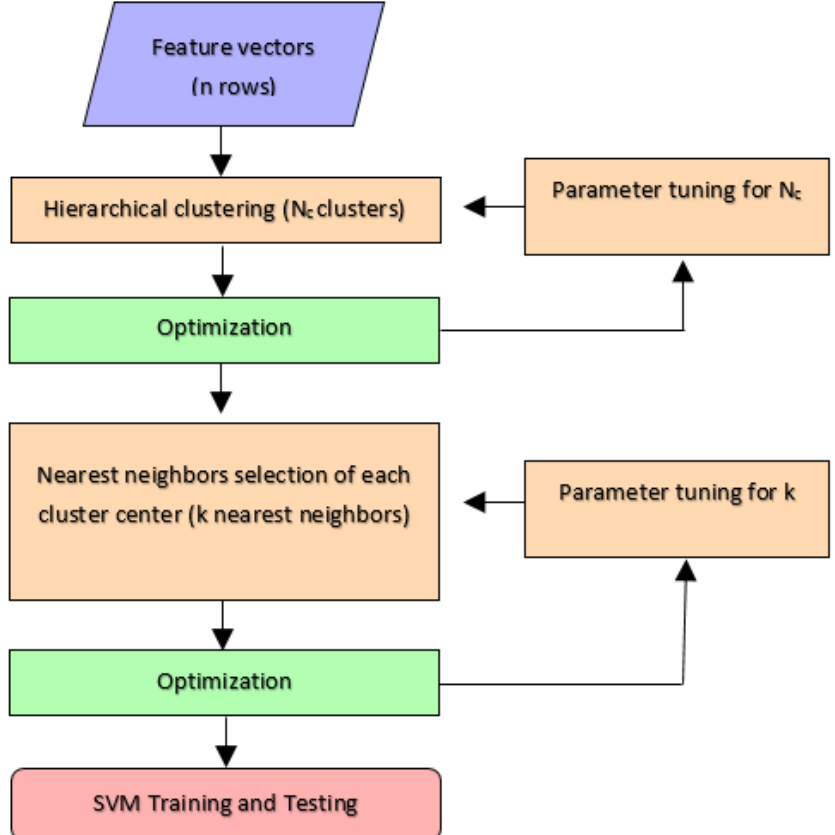
Figure 4. Sample reduction by hierarchical